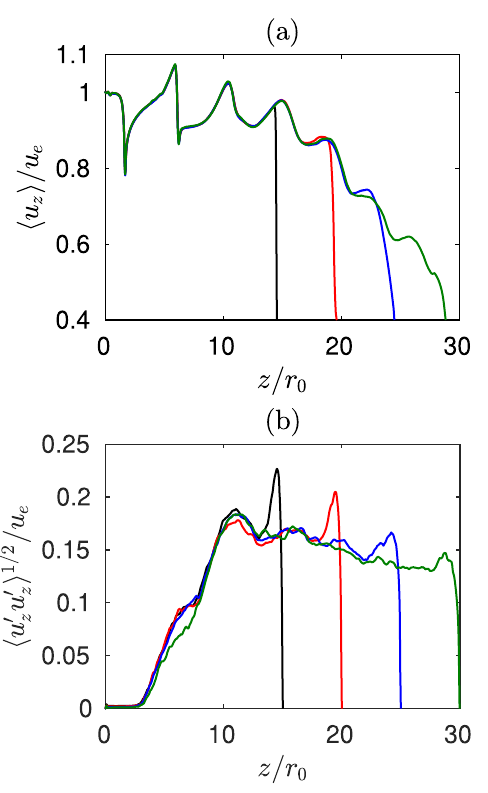
Figure 5. Variations of (a) the mean axial centerline velocity h u i / u z e and (b) the axial turbulence intensity at r = r 0 for L = 15 r 0 , L = 20 r 0 , L = 25 r 0 and L = 30 r 0 .